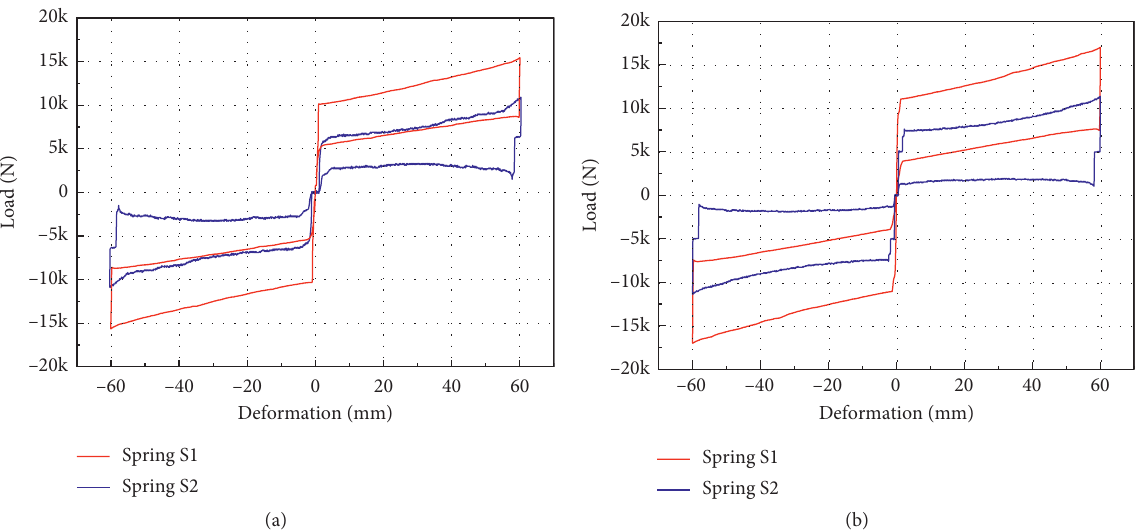
Figure 4: Load-deformation response of SCVF brace with different springs. (a) 5 mm deflection of the friction plate. (b) 7.5 mm deflection of the friction plate.